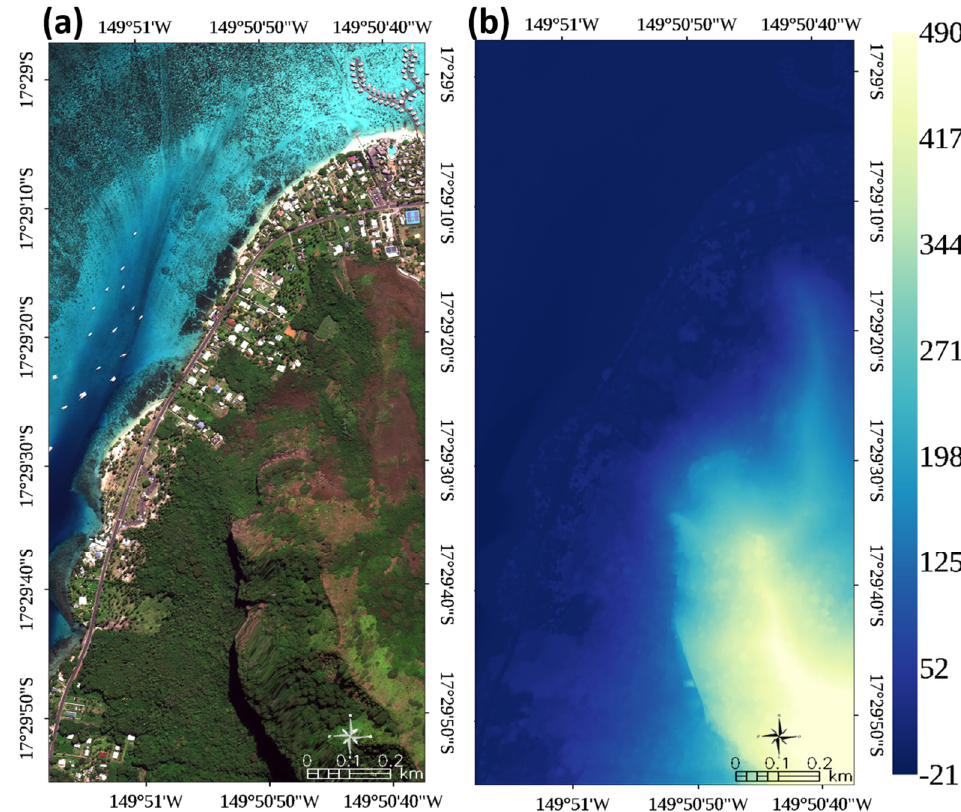
Figure 4. ( a ) Natural-coloured orthorectified WorldView-3 imagery of the study area; ( b ) topobathymetric digital surface model (in m) derived from the combination of a photogrammetry-based stereo-panchromatic imagery for land and a ratio transform model for sea, both derived from the same WorldView-3 stereo-imagery. The colour scale on the right indicates the estimated height and depth below sea-level of different parts of the image.